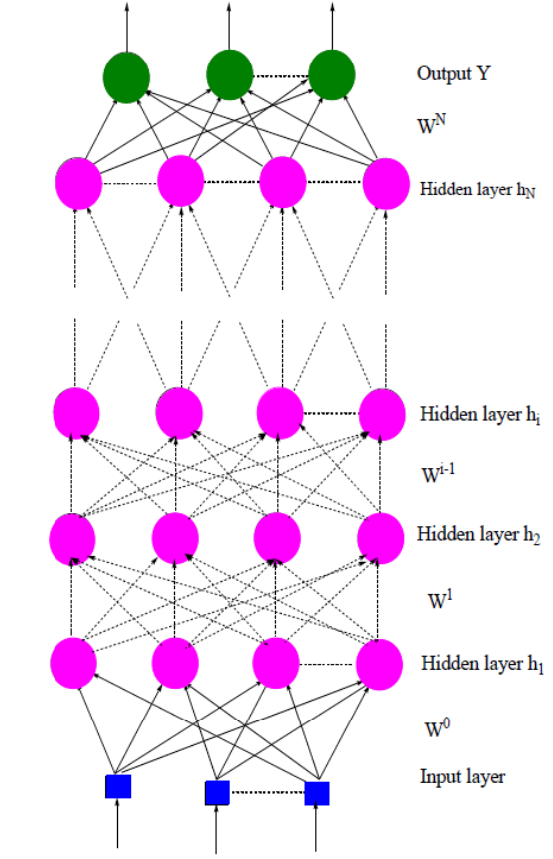
Figure 3 Structure of Multi-Layer Perceptron Neural Networks (Ramchoun et al.